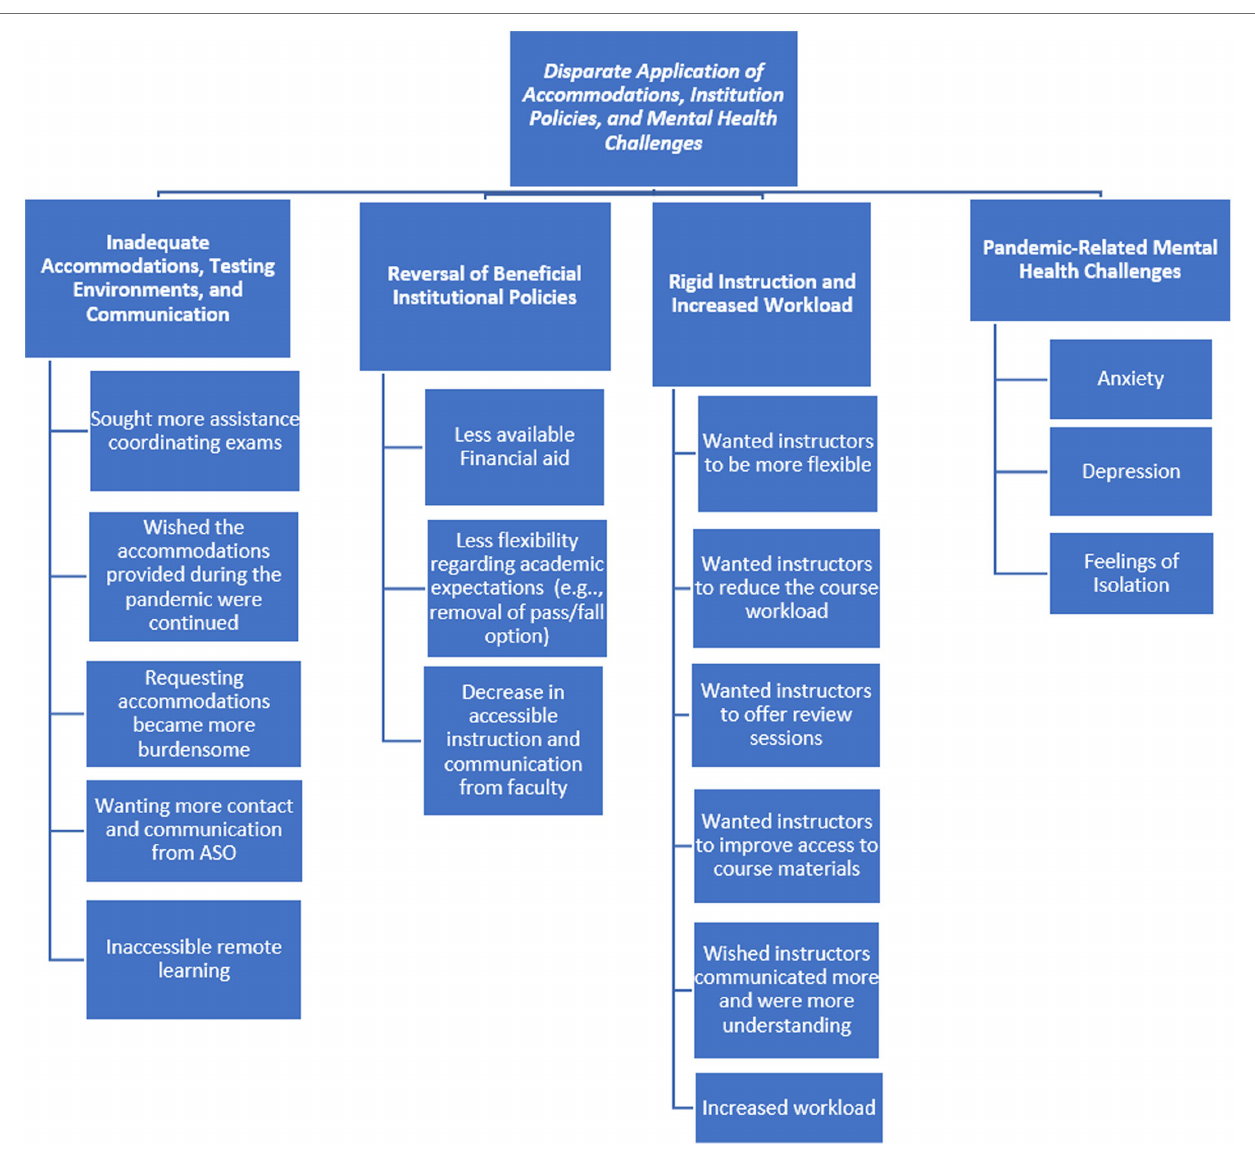
FIGURE 2 | Ongoing pandemic challenges during Fall/Spring 2020–2021 semesters coding